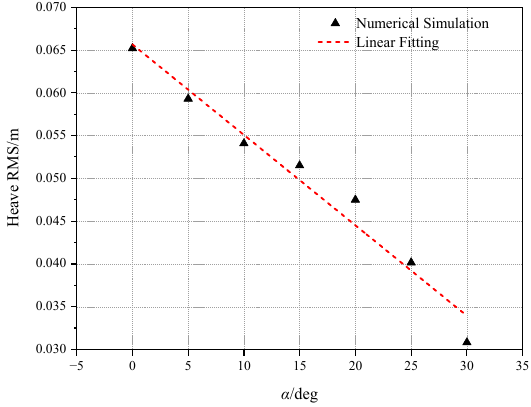
Figure 14. Heave responses with different inclined angles.